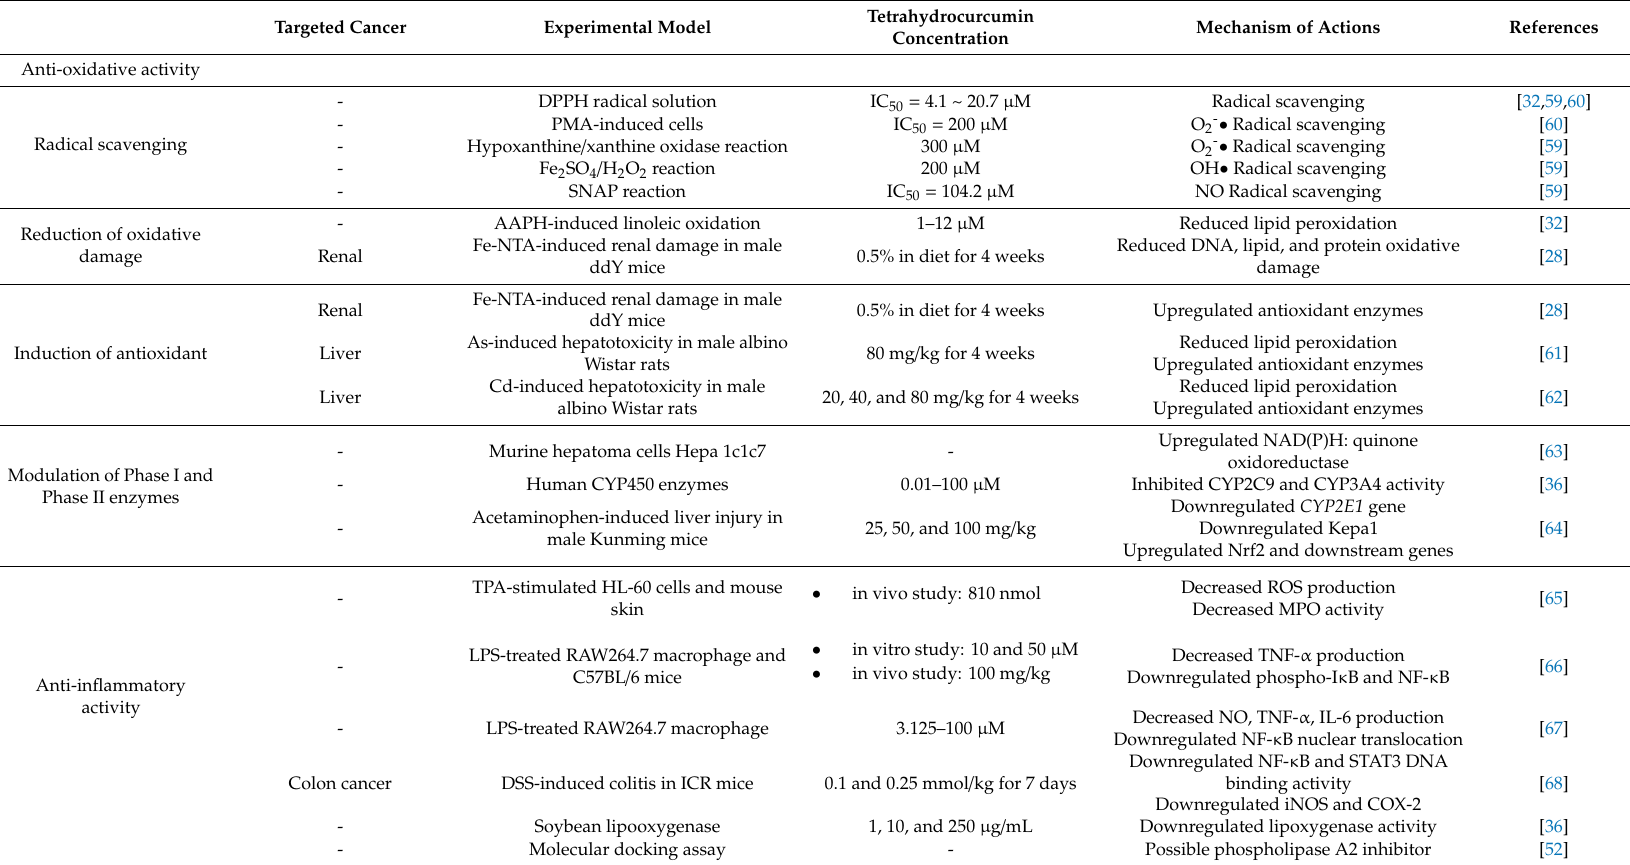
Table 1. Proposed anti-cancer mechanisms and molecular targets of